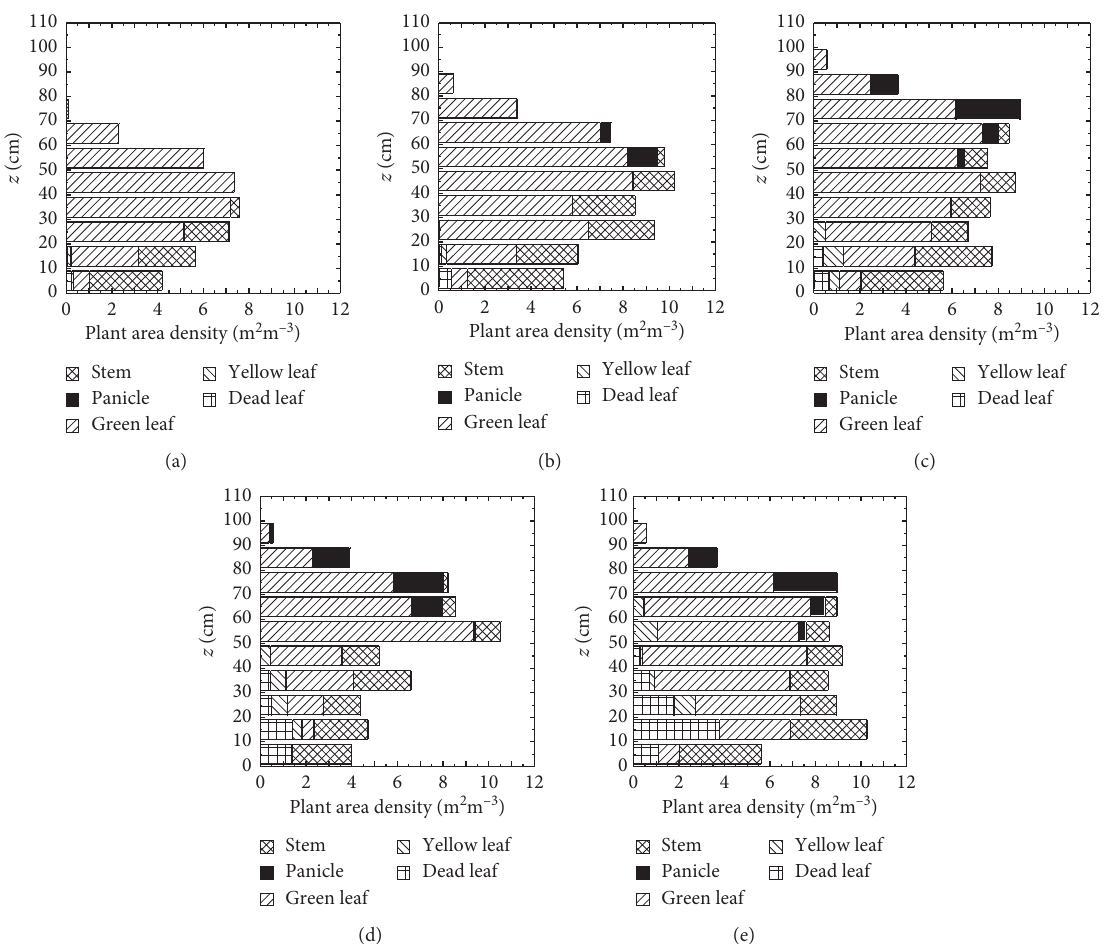
Figure 4: Observed vertical profiles of plant area density (PAD) in the rice paddy field from July 18 to August 15, 2014. (a) July 18, (b) July 25, (c) August 1, (d) August 8, and (e) August